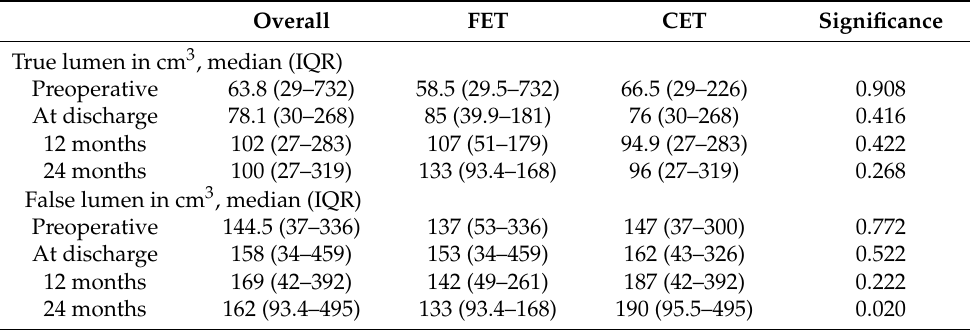
Table 2. TL, FL, and total lumen in cm³ at the respective times of measurement. Overall FET CET Significance